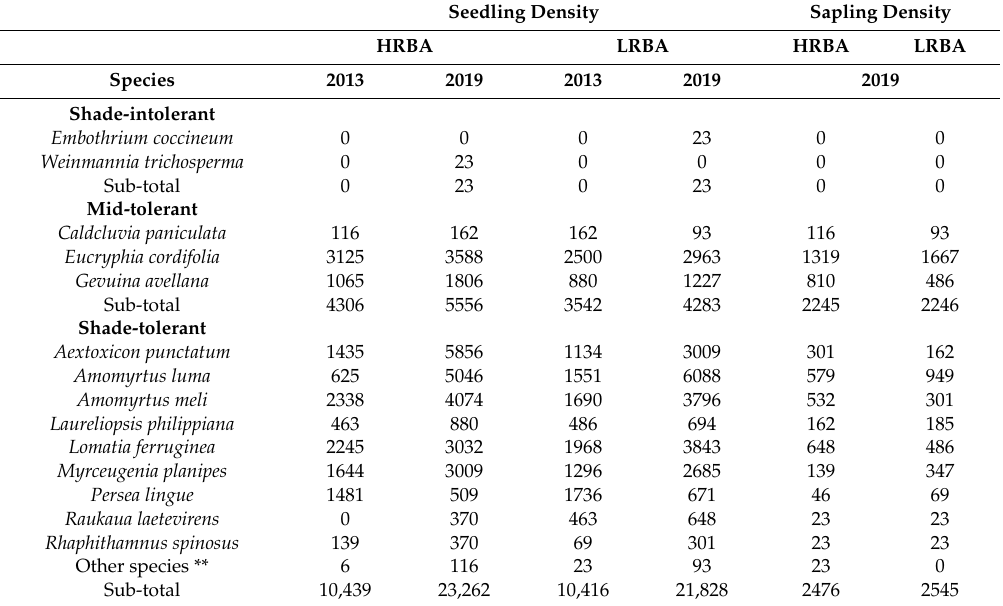
Table 2. Mean and standard deviation of the regeneration density (per ha values) of seedlings and saplings according to species and treatment (HRBA and LRBA) in Los Riscos (LR) following the cuts (2013) and six years after the cuts (2019). Table S8 in the Supplementary Materials provides both the mean and standard deviation.